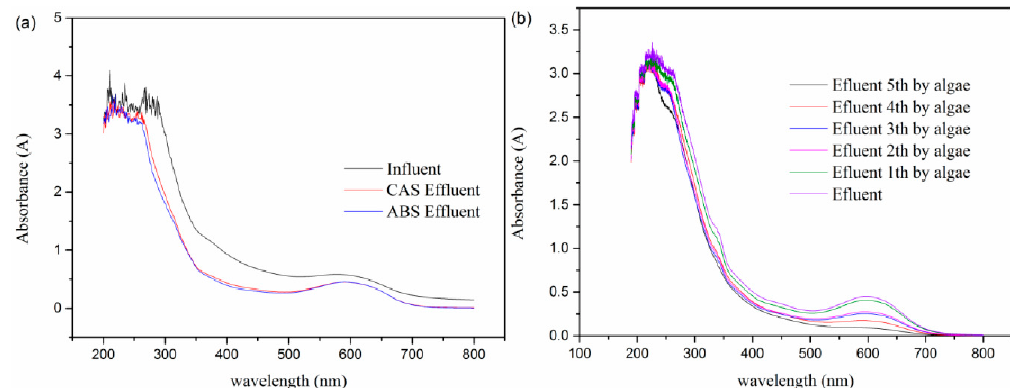
Figure 11. Influent and effluent UV full-wavelength scanning of processed using the ABS and CAS systems ( a ), and effluent UV full-wavelength scanning of processed using mixed algae ( b ).